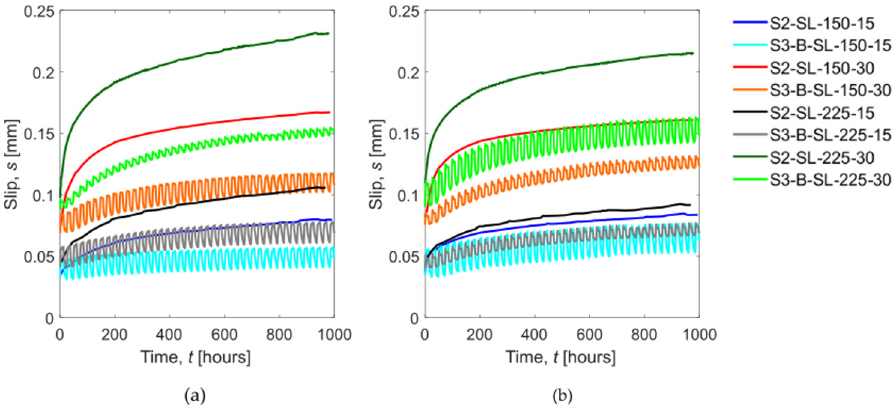
Figure 7. Comparison of the slip evolution with time obtained in series S2 and S3-B for groove thicknesses of: ( a ) 7.5 mm; ( b ) 10 mm.